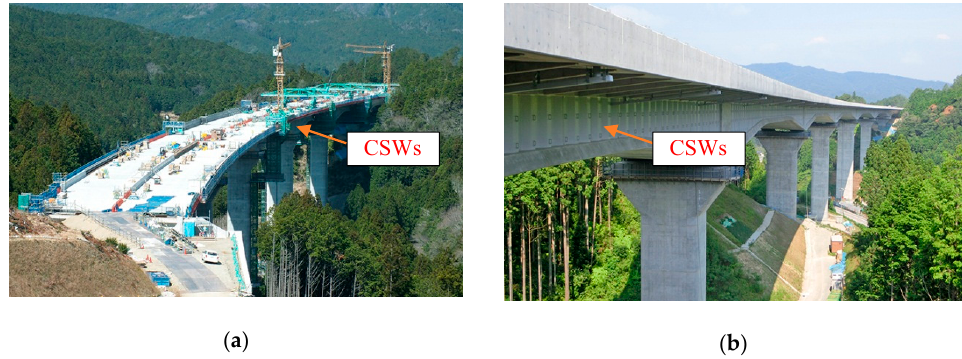
Figure 1. Shintogawa Bridge in Japan (completed in 2013): ( a ) Top view; ( b ) Side view. CSWs: corrugated steel webs.